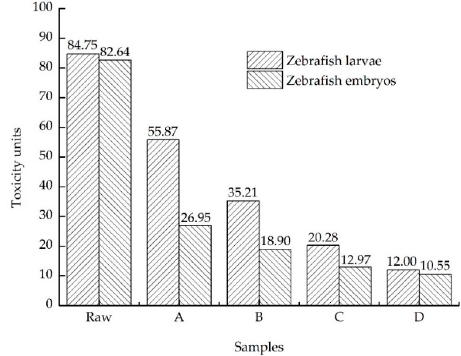
Figure 2. Toxicity units of different samples by zebrafish larvae and zebrafish embryos. Raw, the raw landfill leachate; sample A, coagulation and sedimentation tank effluent; sample B, anaerobic tank effluent; sample C, electrochemical oxidation tank effluent; and sample D, aerobic tank